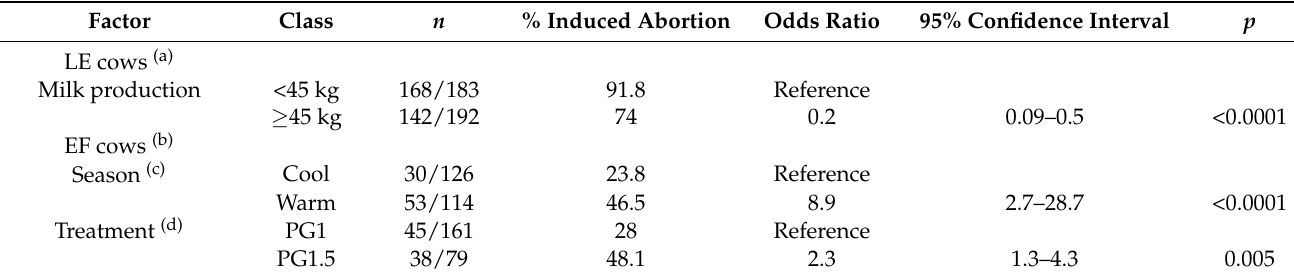
Table 2. Odds ratios for induced abortion rate of the variables entered in the final logistic regression model for cows with late embryos ( n = 375) and cows with early fetuses ( n =